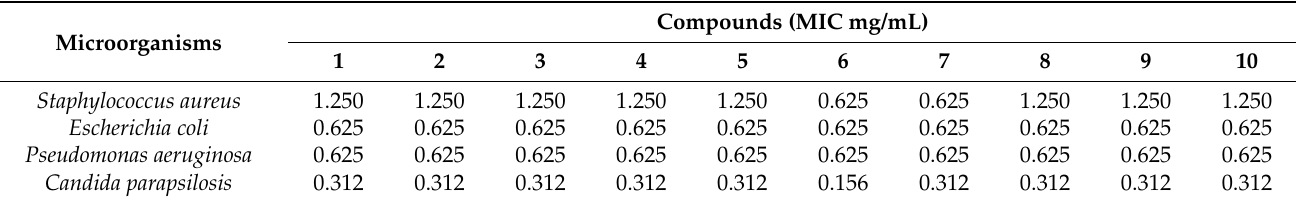
Table 5. Antibacterial and antifungal activities of azulene-containing chalcones 1 – 10 .